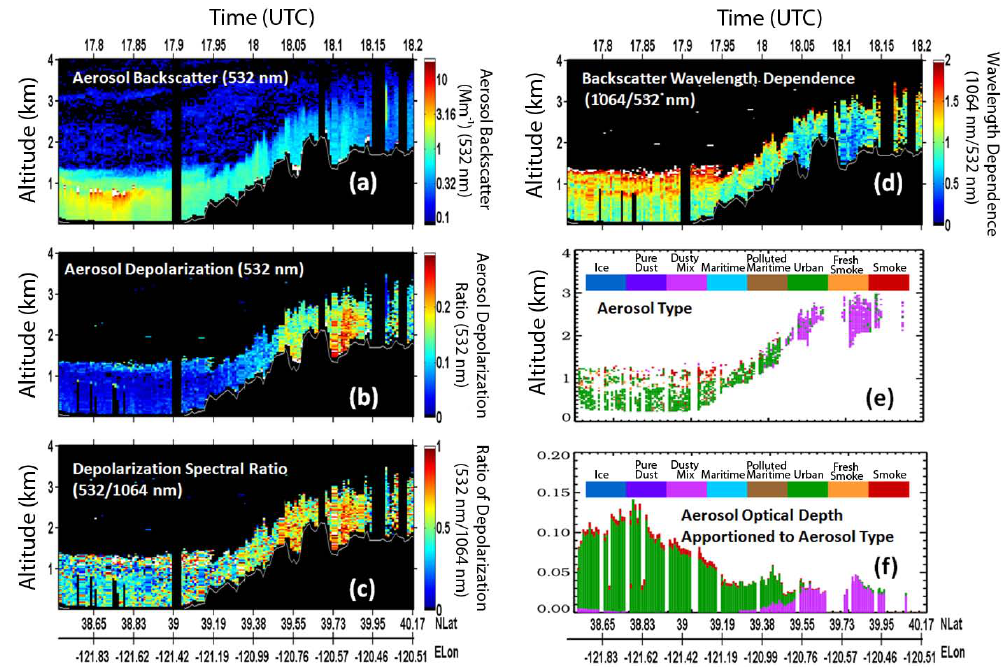
Fig. 22. (a) Aerosol backscatter (532nm), (b) aerosol depolarization (532nm), (c) ratio of aerosol depolarization (532/1064nm), (d) backscatter wavelength dependence ((1064/532nm) measured by the airborne HSRL between 17:45–18:12 UT on 19 June. This portion of the B200 flight covered about 160km between the Sacramento area (left) and the mountains east of Sacramento (right). The dark area in the bottom part of the images represents the ground surface. (e) Aerosol type inferred from the HSRL measurements of aerosol intensive parameters. (f) AOD apportioned to aerosol